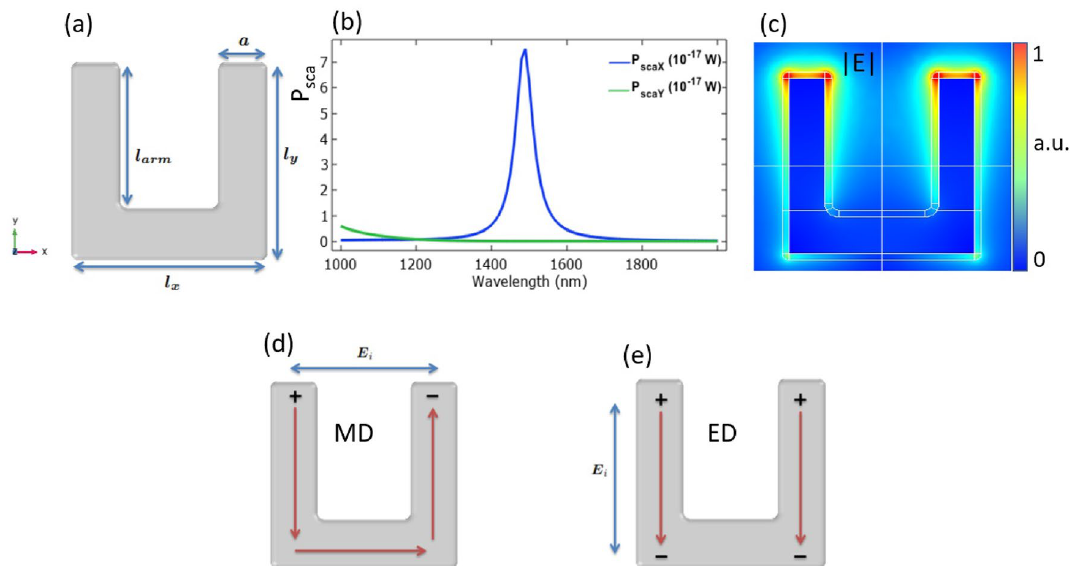
Figure 7. Sketch of the proposed air-surrounded gold SRR and ( b ) its scattering spectrum. ( c ) The electric field norm around (cid:31) = 1.5 µ m reveals the LSPR. The corners and edges of the metallic structure are smoothed by a curvature of 5 nm to avoid numerical singularities. The plot is obtained by using COMSOL Multiphysics v5.5—https:// www. comsol. com. ( d ) Schematics of the linear current distributions at the magnetic dipole, MD, and ( e ) electric dipole, ED, resonances of the